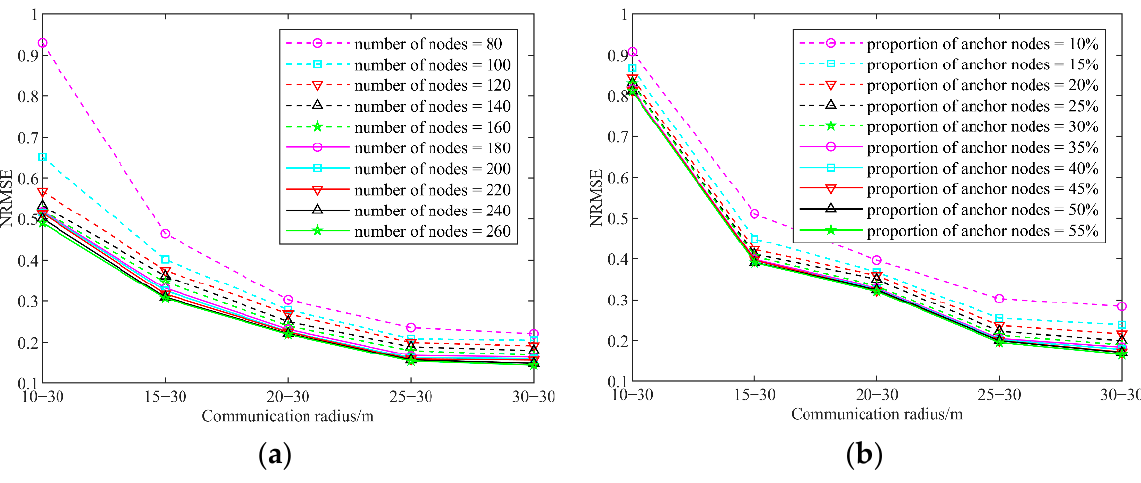
Figure 6. Effect of parameter variation on positioning accuracy: ( a ) change in number of nodes; ( b ) change of anchor node ratio.